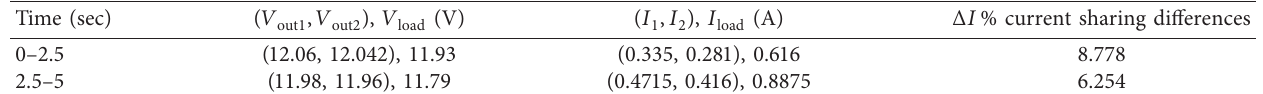
Table 3: Simulation results for the modified droop method.